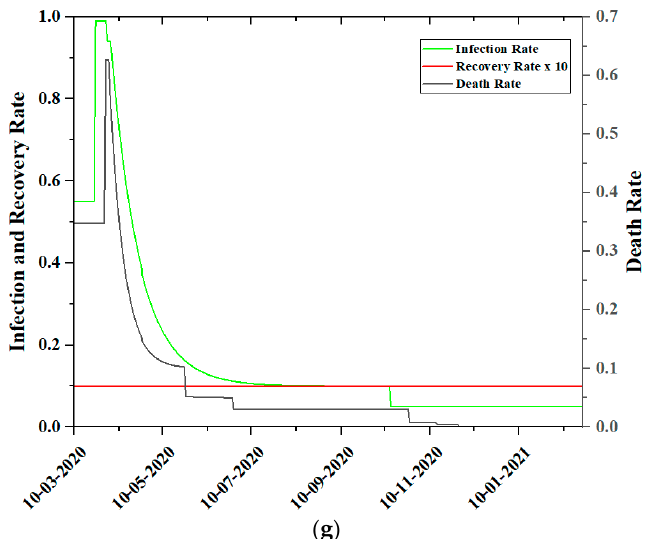
Figure 6. Kinematic of infection, recovery and death for Indian COVID-19 outbreak using ( a ) G ( b ) PS ( c ) PSO ( d ) G + PS ( e ) G + PSO ( f ) G + PS + G ( g ) G + PSO + G.